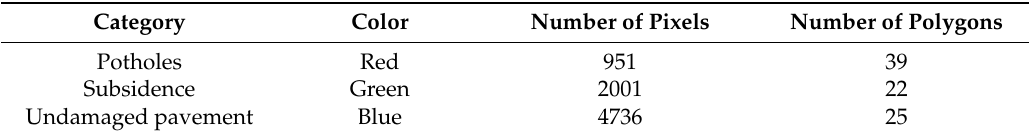
Table 5. Training samples.